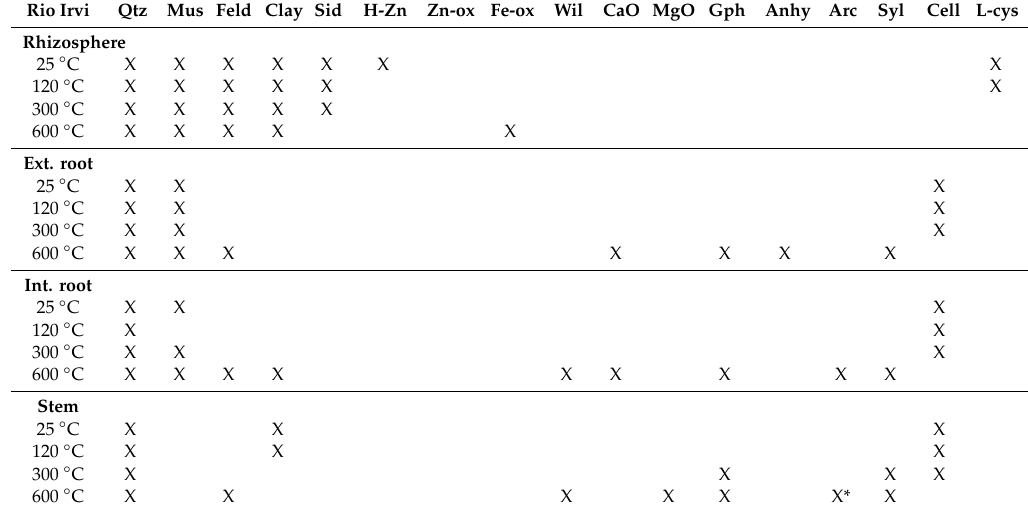
Table 2. Mineral assemblages of samples from Rio Irvi at the di ff erent temperatures of the heating ramp. Abbreviation are: Qtz, quartz; Mus, muscovite; Feld, feldspars; Clay, clayey minerals; Sid, siderite; H-Zn, hydrozincite; Zn-ox, zinc oxides; Fe-ox, iron oxides; Wil, willemite; CaO and MgO, calcium and magnesium oxides; Gph, graphite; Anhy, anhydrite; Arc, arcanite; Syl, sylvite; Cell, cellulose; L-cys, L-cysteine. Rio Irvi Qtz Mus Feld Clay Sid H-Zn Zn-ox Fe-ox Wil CaO MgO Gph Anhy Arc Syl Cell